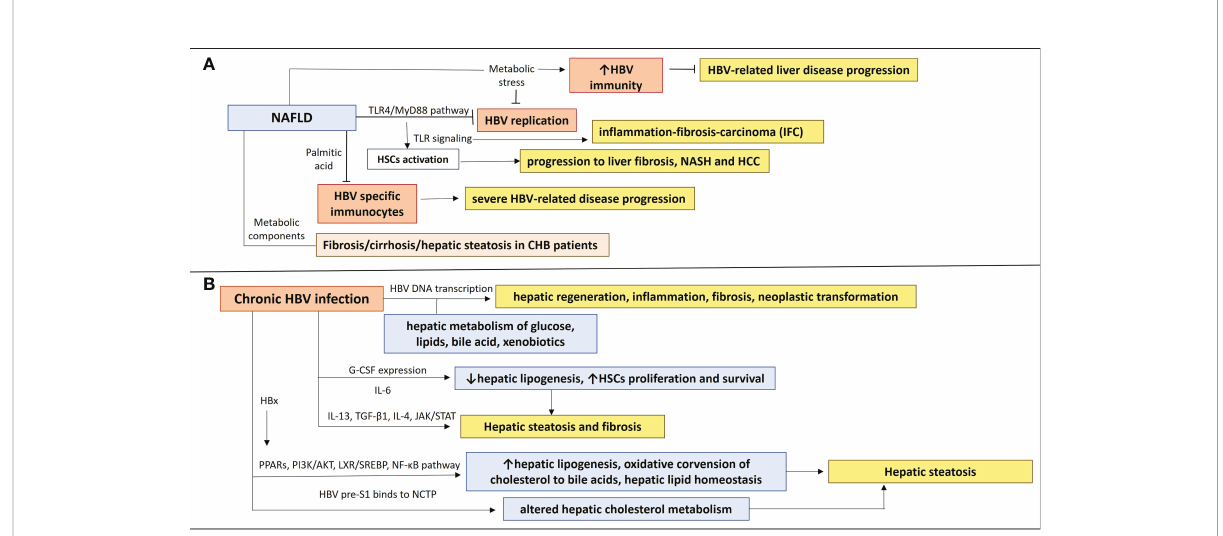
FIGURE 1 The NAFLD-HBV interplay in chronic liver disease progression. (A) NAFLD effects on chronic HBV infection and chronic liver disease progression. Activation of TLR4/Myd88 pathway in NAFLD inhibits HBV replication and induction of TLRs contributes to HSCs activation, leading to in fl ammation- fi brosis-carcinoma (IFC) and progression to liver fi brosis, NASH and HCC. Production of saturated fatty acid palmitic acid suppresses HBV speci fi c immunocytes, resulting in insuf fi cient immune responses, which could be associated with a more severe HBV-related disease progression. Metabolic components have been implicated in liver disease progression and NAFLD development in CHB patients, as they were correlated with fi brosis/cirrhosis and hepatic steatosis. NAFLD-associated metabolic stress restores HBV-suppressed immunity, preventing from severe HBV-related liver disease progression. (B) Chronic HBV infection effects on NAFLD and chronic liver disease progression. Transcription of HBV DNA is related to hepatic metabolism of glucose, lipids, bile acid, and xenobiotics and may play a role in the inhibition or promotion of hepatic regeneration, in fl ammation, fi brosis, and neoplastic transformation. A differential expression of IL-13, G-CSF, CCL11, IL-6 and IL-4 may be implicated in development of hepatic steatosis and fi brosis in HBV patients, through affecting hepatic lipogenesis and HSCs proliferation and survival. HBx protein can induce PPARs and signaling pathways (PI3K/AKT, LXR/SREBP, NF- kb ), having an impact on hepatic lipogenesis, oxidative conversion of cholesterol to bile acids, hepatic lipid homeostasis and therefore hepatic steatosis. HBV pre-S1 binds to NCTP, leading probably to altered hepatic cholesterol metabolism and hepatic